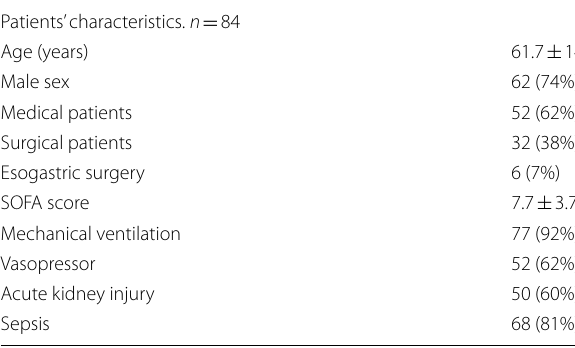
Data are expressed as mean SD, or n (%); SOFA: Sequential Organ Failure ± Assessment SOFA scores can range from 0 (no organ failure) to 24 (most severe level of multiorgan failure)